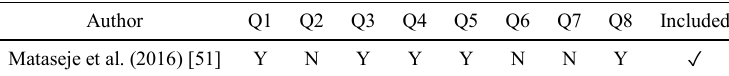
Table 3. JBI critical appraisal checklist for case